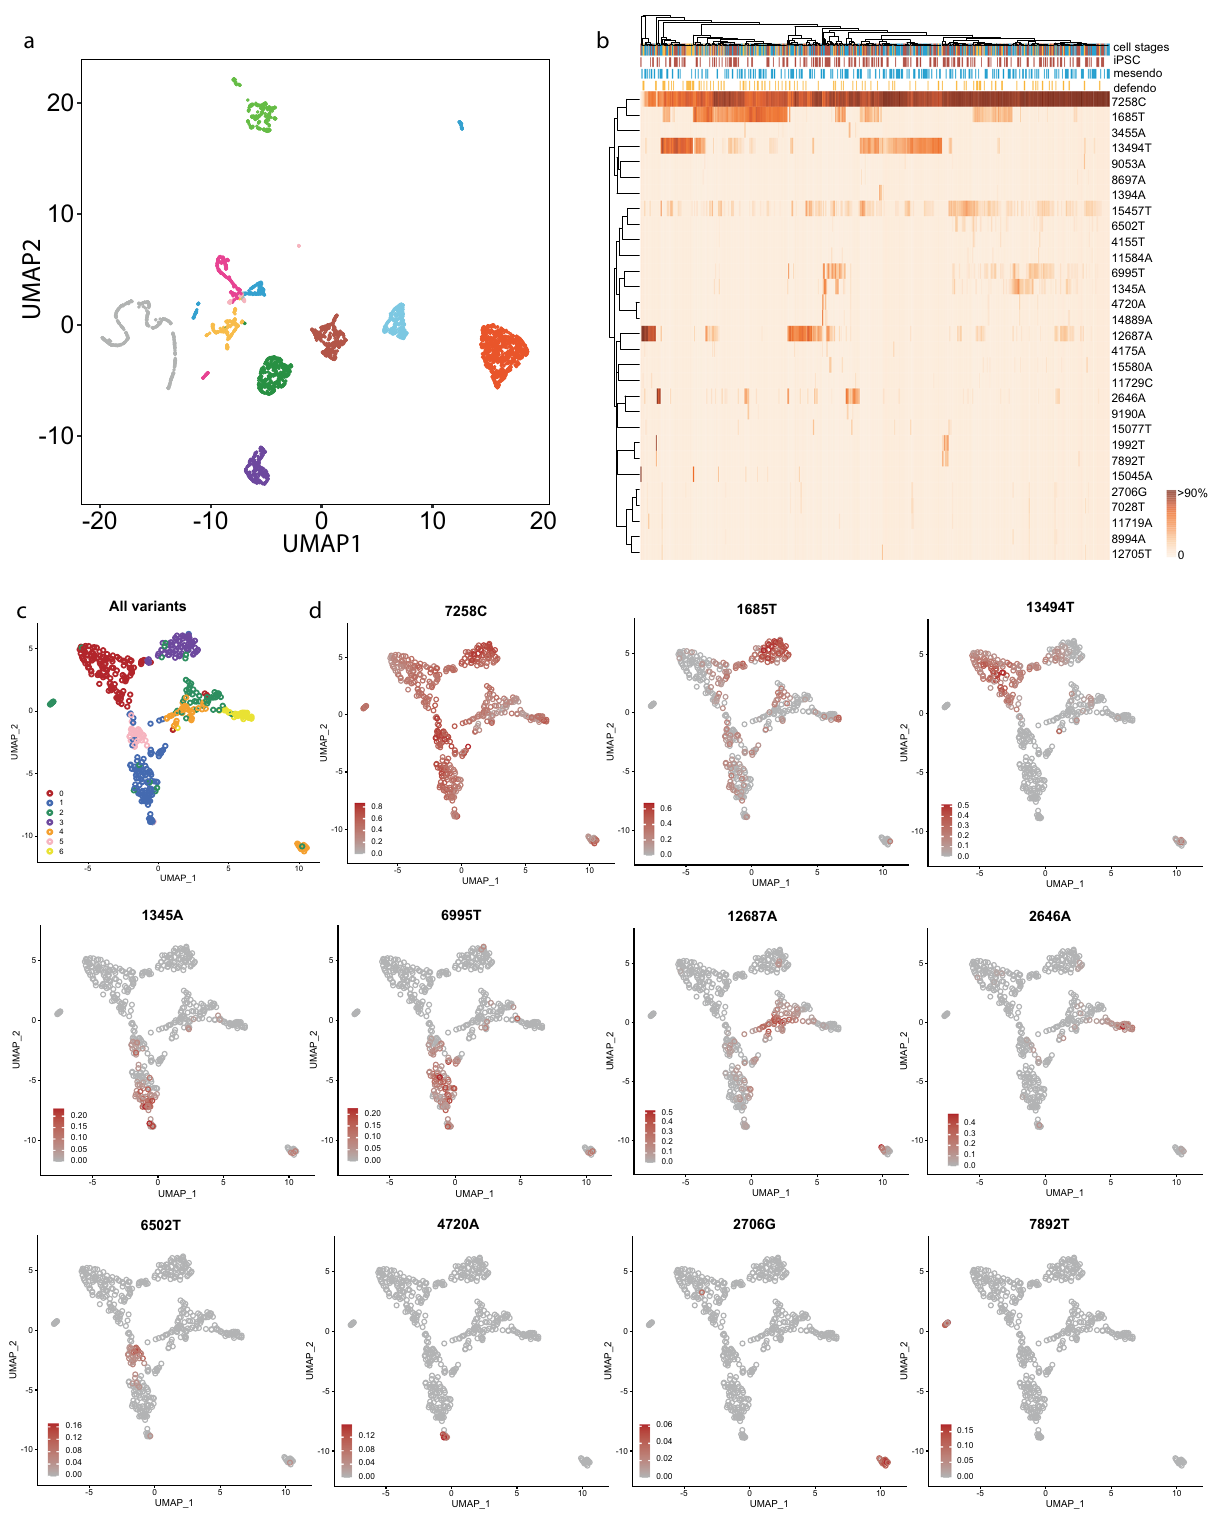
Fig. 6 Lineage tracing using mtDNA variants reveals multiple sub-clones within each cell line. a UMAP plot of mitochondrial mutation pro fi les, based on 11 cell lines with at least 300 cells. Single cells were separated according to their origins based solely on the mtDNA heteroplasmic variant data. Cells are coloured by each cell line of origin. b An example of hierarchical clustering by the mitochondrial genotyping (rows) for the single cells within a single-cell line. Cells are coloured by their cell stages (columns). Colour bar = heteroplasmy fraction. c , d An example of UMAP plot of mtDNA mutation pro fi les from a single-cell line, with cells coloured by the de fi ned cluster ( c ), and heteroplasmy fractions of speci fi c mutations observed in a cell line ( d ). The mutations are labelled at the top of the